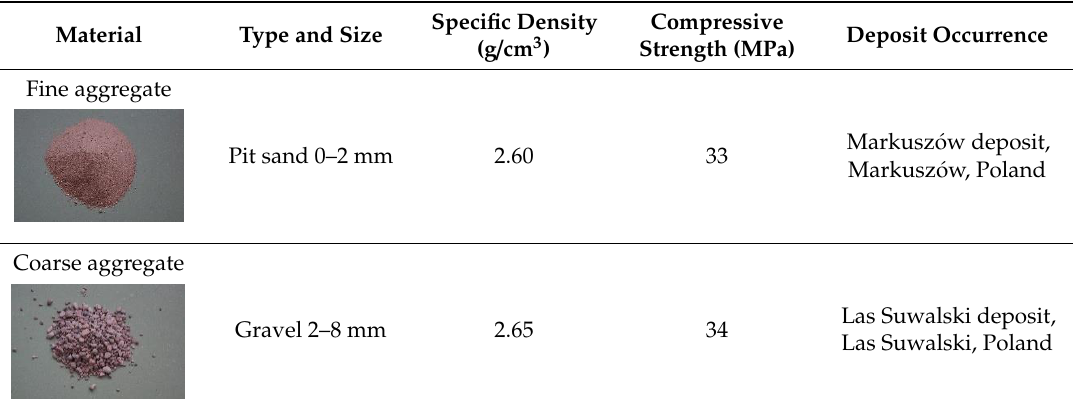
Table 3. Properties of aggregates used in this study.